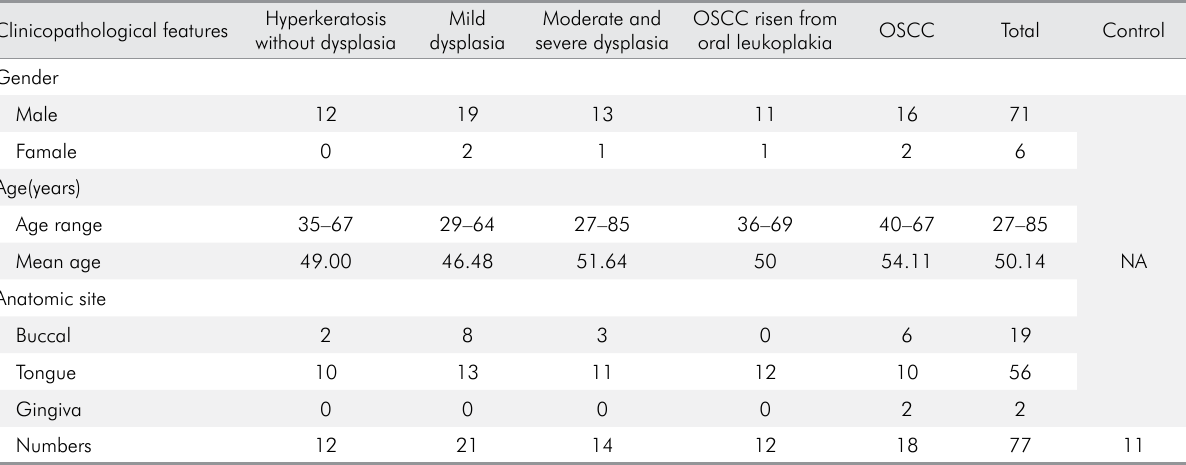
Table 2. The samples were grouped according to histopathological grading and the specific clinical details after grouping. Clinicopathological